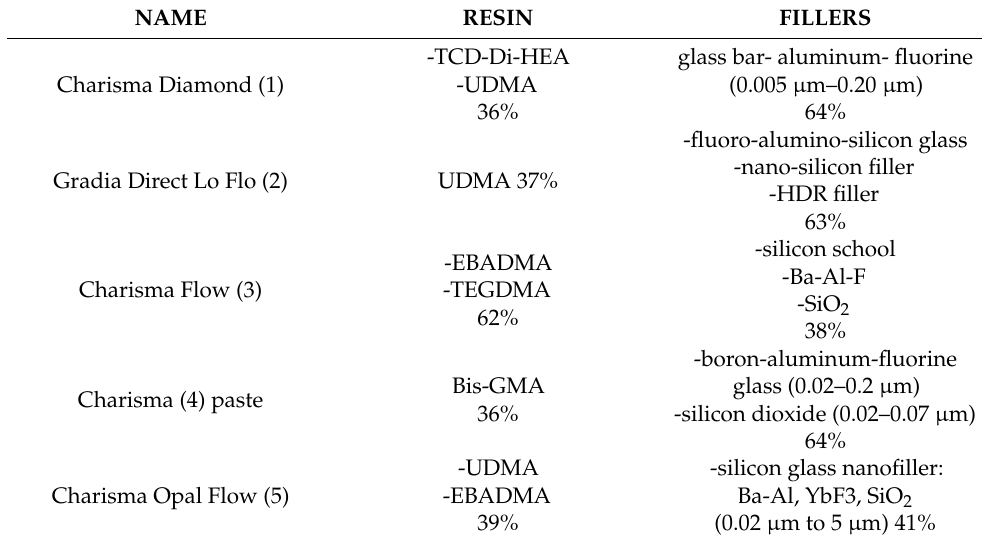
Table 1. As part of this work, five different series of hybrid composites with nano-fillers were